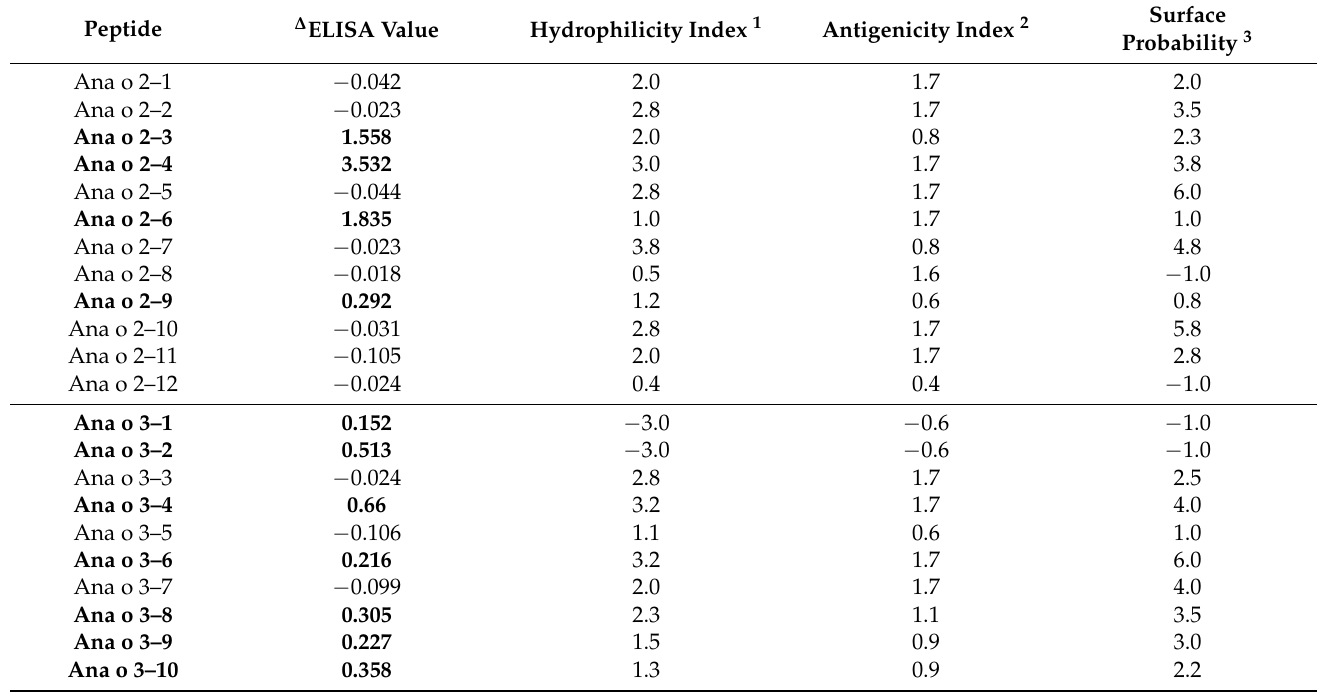
1 . Peak values correspond to lane 7 of Figure 3. 2 . Peak values correspond to lane 8 of Figure 3. 3 . Peak values correspond to lane 9 of Figure 3. ∆ ELISA values are calculated by the peptide sample OD value minus the OD value of the negative control with those above 0 written in